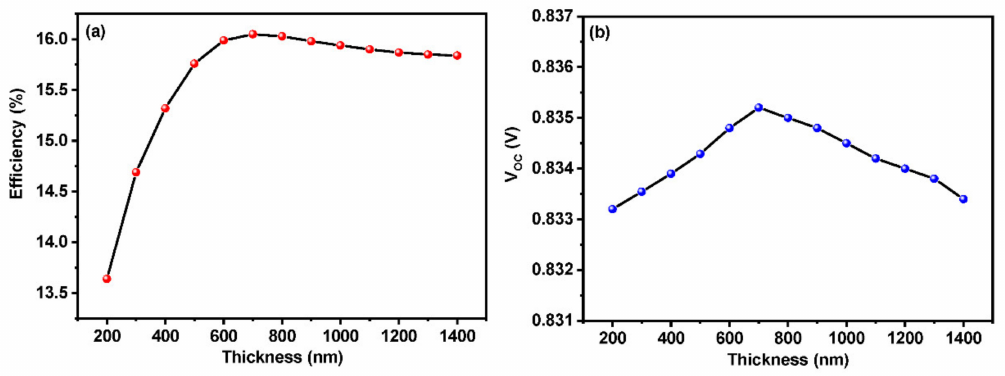
Figure 3. Effect of absorber layer thickness on ( a ) efficiency and ( b ) V oc .